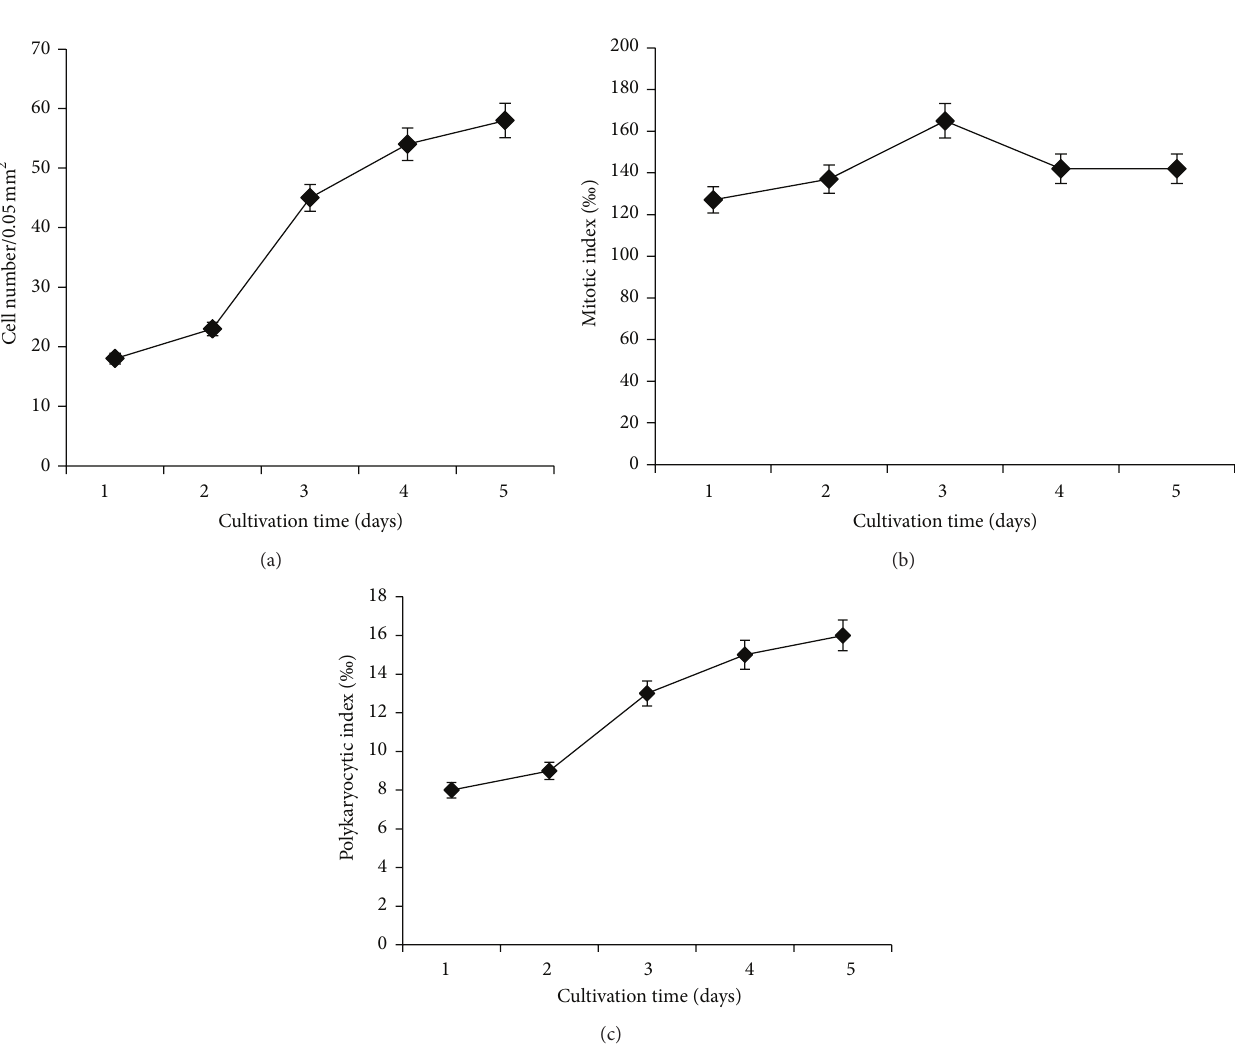
The samples were fixed for analysis in 96% ethanol and then stained by hematoxylin and eosin (H&E). The total number of cells and the count of mitoses and polykaryocytes (2 or more nuclei) were determined under optical microscope (Axioscope, Germany) at 1000x magnification within a grid area of 0.05 mm 2 . Mitotic index and PKI were adjusted to 1000 cells ( ‰ ) . Parallely, cellular vital indices were evaluated within the intact cellular